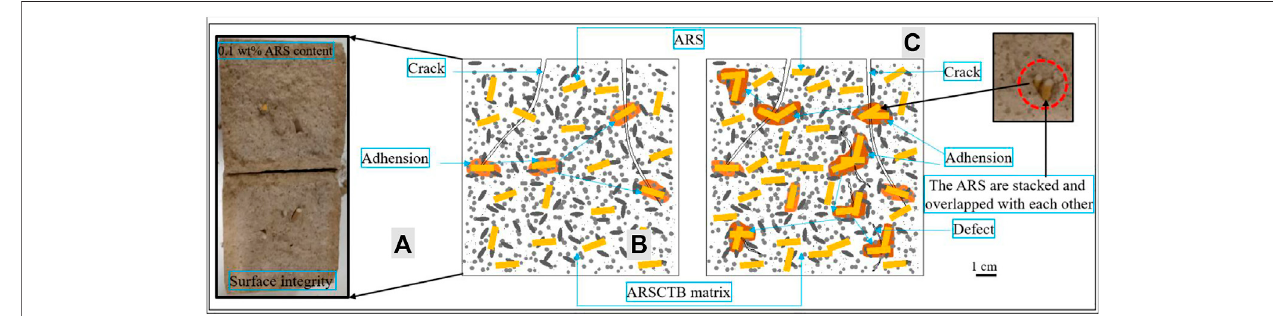
FIGURE 5 | Two-dimensional distribution diagram of ARS ( A : 0.1 wt%; B : 0.4 wt%).